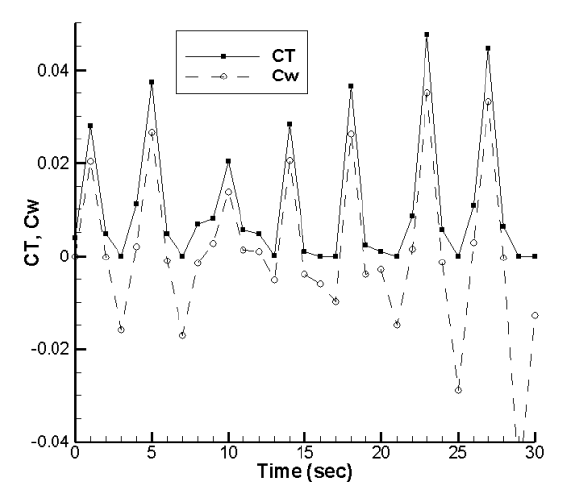
Figure 24. Time histories of the thrust C T (t) and added wave resistance C W (t) coefficients, numerical experiment #1.